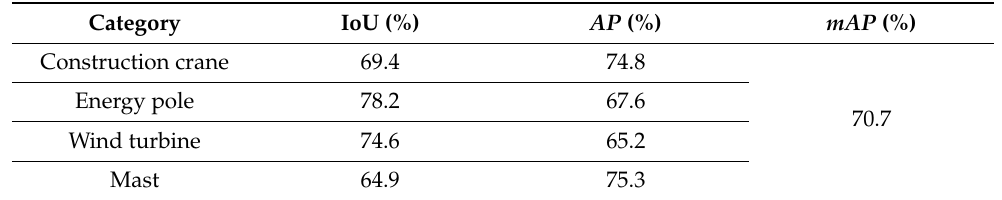
Table 3. Accuracy of test results in various